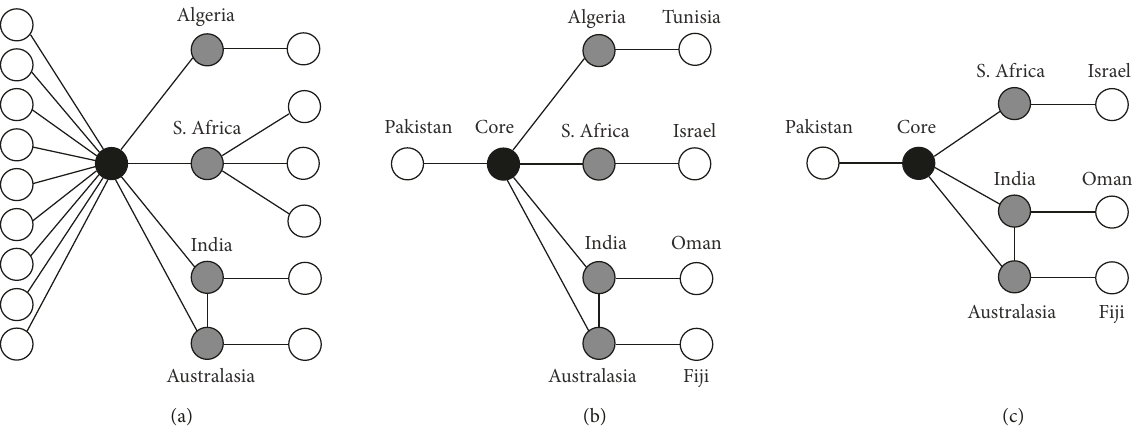
Figure 6: Clustering with threshold 125M USD: (a) CSP network; (b) reduction of false twin vertices; (c) CSP structure.